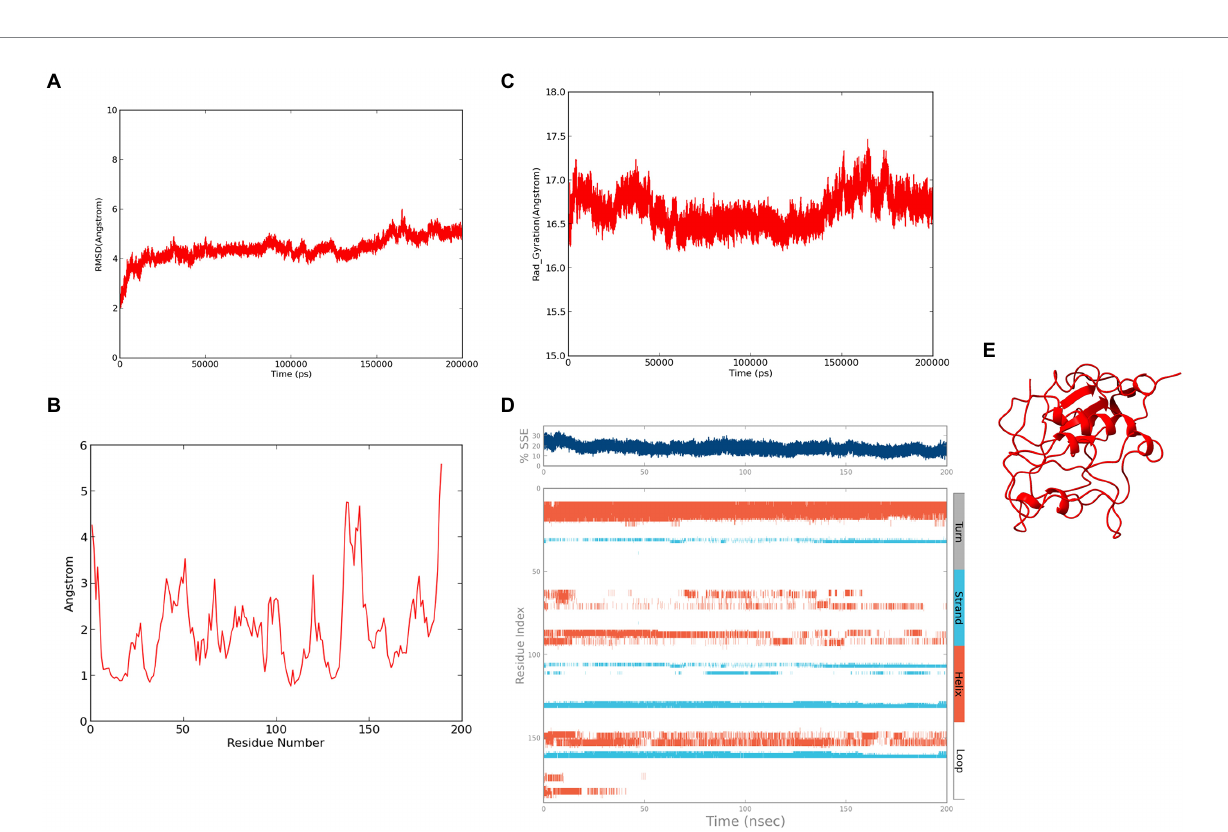
FIGURE 6 Molecular Dynamics simulation of ASP_NL4-3: (A) Root Mean Square Deviation plot of ASP_NL4-3 during the 200 ns simulation period. (B) Root Mean Square Fluctuation plot of ASP_NL4-3 during 200 ns simulation period. (C) Radius of gyration plot of ASP_NL4-3 during 200 ns simulation period. (D) Secondary structure elements of ASP_NL4-3 during simulation period (Orange-helices; Blue-strands; Gray-turns; White-loops). (E) Final frame structure of ASP_NL4-3 after 200 ns